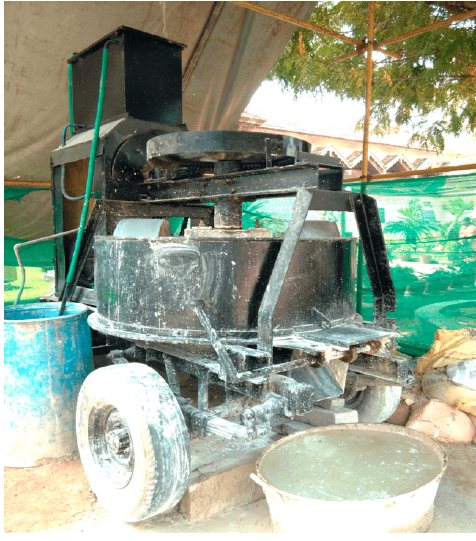
Figure 1. Traditional pug mill mixer .